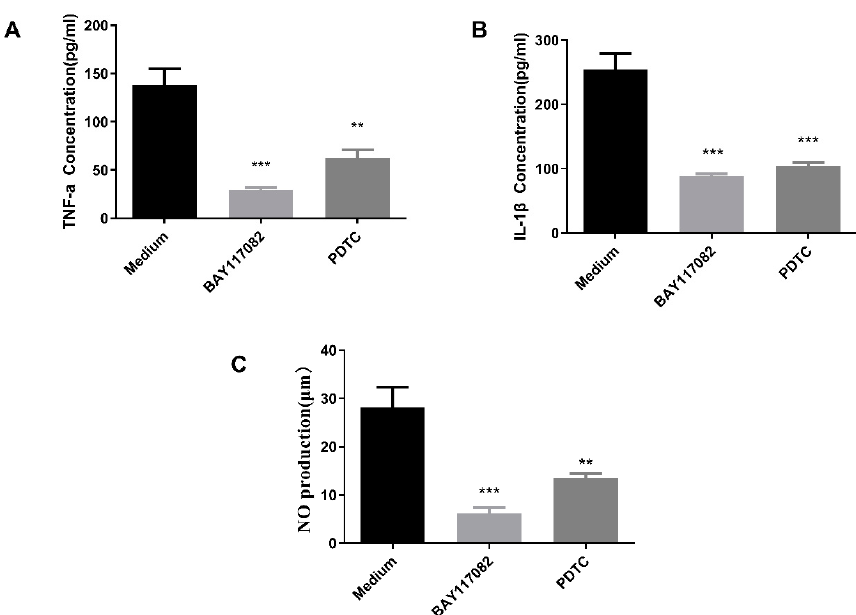
Figure 8. Effects of NF- κ B inhibitors on TNF- α ( A ), IL-1 β ( B ) and NO ( C ) production in GEP-1-treated RAW264.7 cells. The macrophages were treated with GEP-1 in the absence or presence of specific pathway inhibitors, and cytokine and NO production in the culture supernatants was determined.